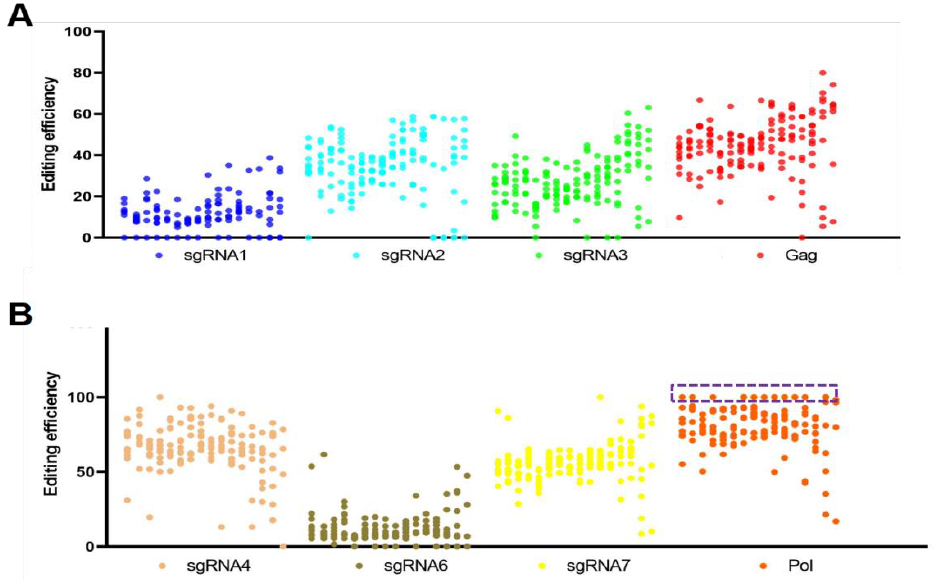
Figure 3. Mi-seq sequencing results of six sgRNA-edited regions on PERV. ( A ) Statistical results of Mi-seq sequencing of sgRNA1, sgRNA2, sgRNA3 and gag region from 157 cell clones. ( B ) Statistical results of Mi-seq sequencing of sgRNA4, sgRNA6, sgRNA7 and pol region from 154 cell clones. The cell clones with the 100% editing efficiency for all the copies of the pol region are boxed in a purple frame.